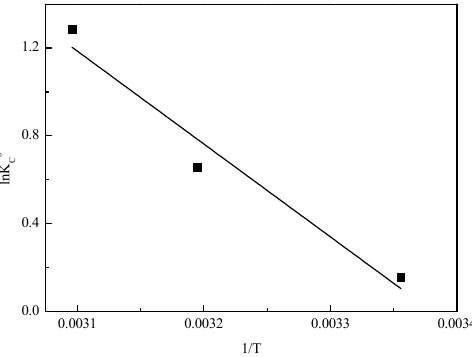
Figure 10. Plot of lnKc 0 versus 1/T on adsorption of VO 3− onto Mg-Fe-Ti-CLDH.